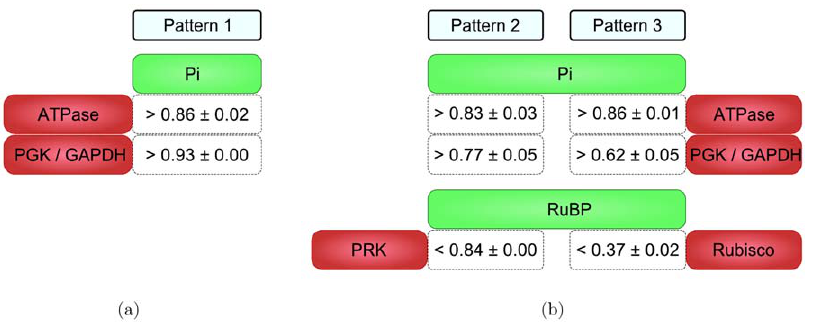
Figure 7. Example patterns with a) two or b) three stability conditions each. For each enzyme-metabolite pair, a threshold for the saturation c is given. Enzymes are marked in red, their reactants are marked in green. Pattern 1 exhibited an average Laplace ratio of 0 : 9918 + 0 : 0018 ( h ~ 528 + 66 : 53 , e ~ 3 : 4 + 1 : 34 ). Pattern 2 affected less training samples because of its less strict threshold on the parameter associated with PGK and GAPDH but also produced more training errors and a lower Laplace value ( L ~ 0 : 99 + 0 h ~ 1068 + 5 : 29 , e ~ 10 + 0 ). Pattern 3 affected an even larger number of hits but nevertheless, it produced fewer training errors than pattern 2. As a consequence, it exhibited the highest Laplace value of all the depicted patterns ( L ~ 0 : 9963 + 0 : 0012 , h ~ 1783 : 67 + 155 : 47 , e ~ 5 : 67 + 2 : 89 ).